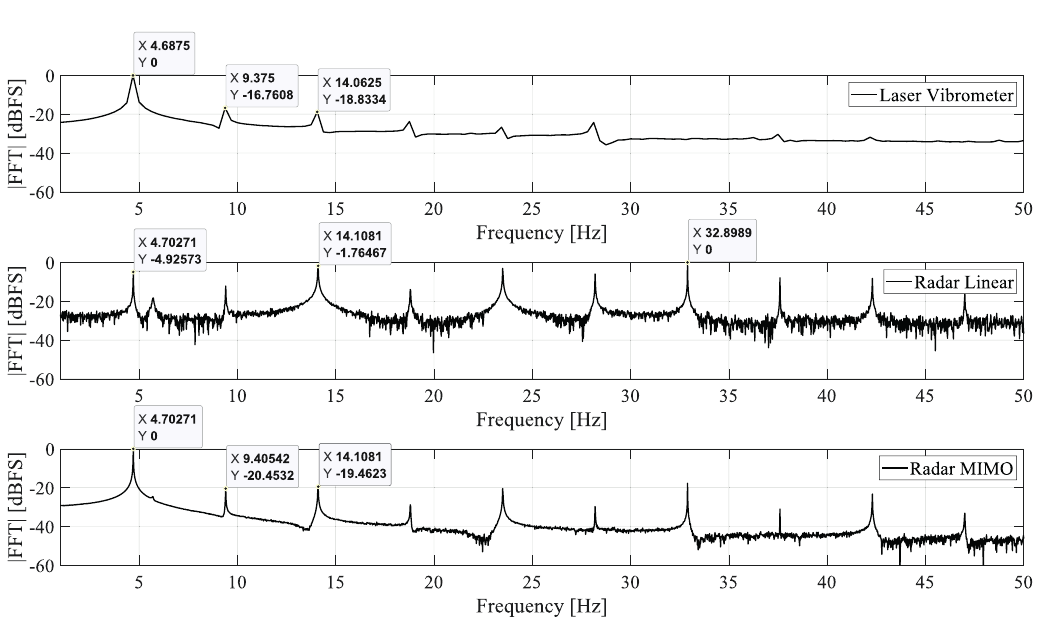
Figure 13. Harmonics comparison between the three measurement techniques used. The depicted spectrum is limited to 50